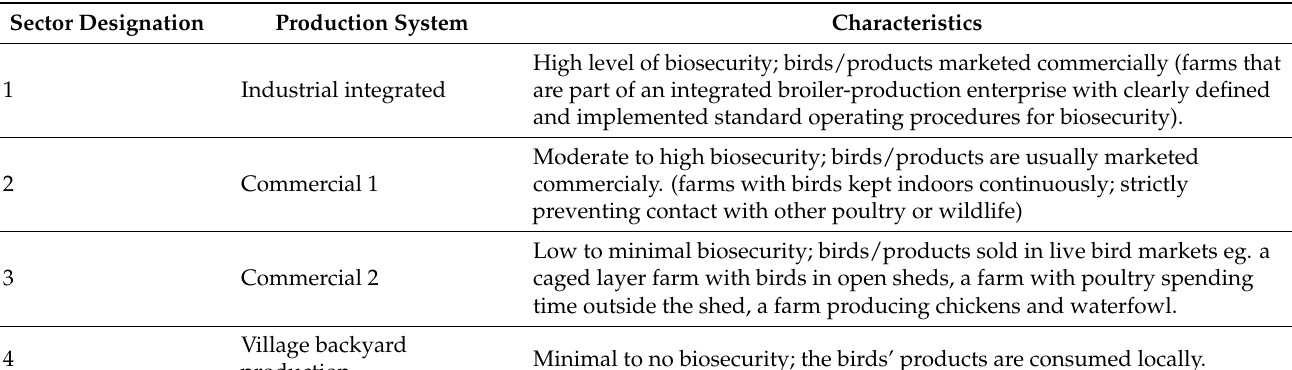
Table 5. FAO classification of poultry production